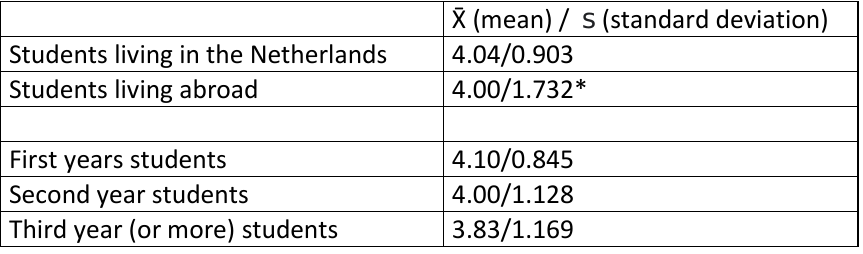
Table 5 "I feel connected with my fellow students"; N=48